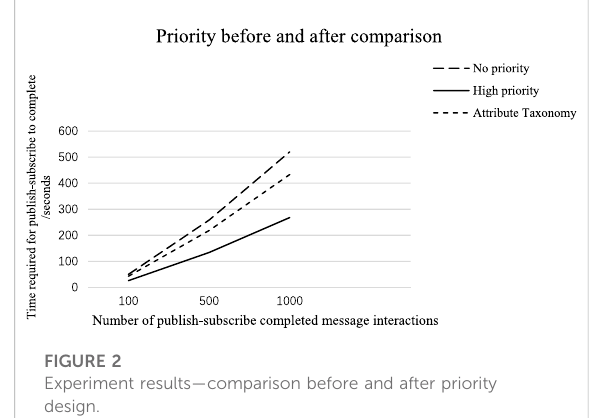
FIGURE 2 Experiment results — comparison before and after priority